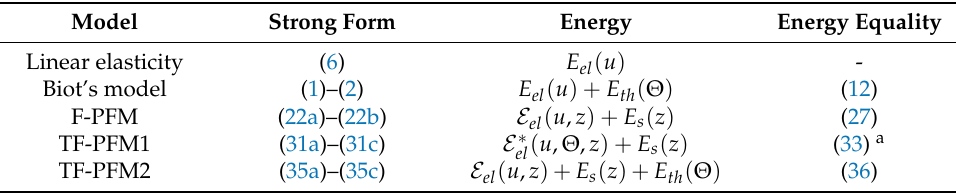
Table 2. Different forms of energy equalities.